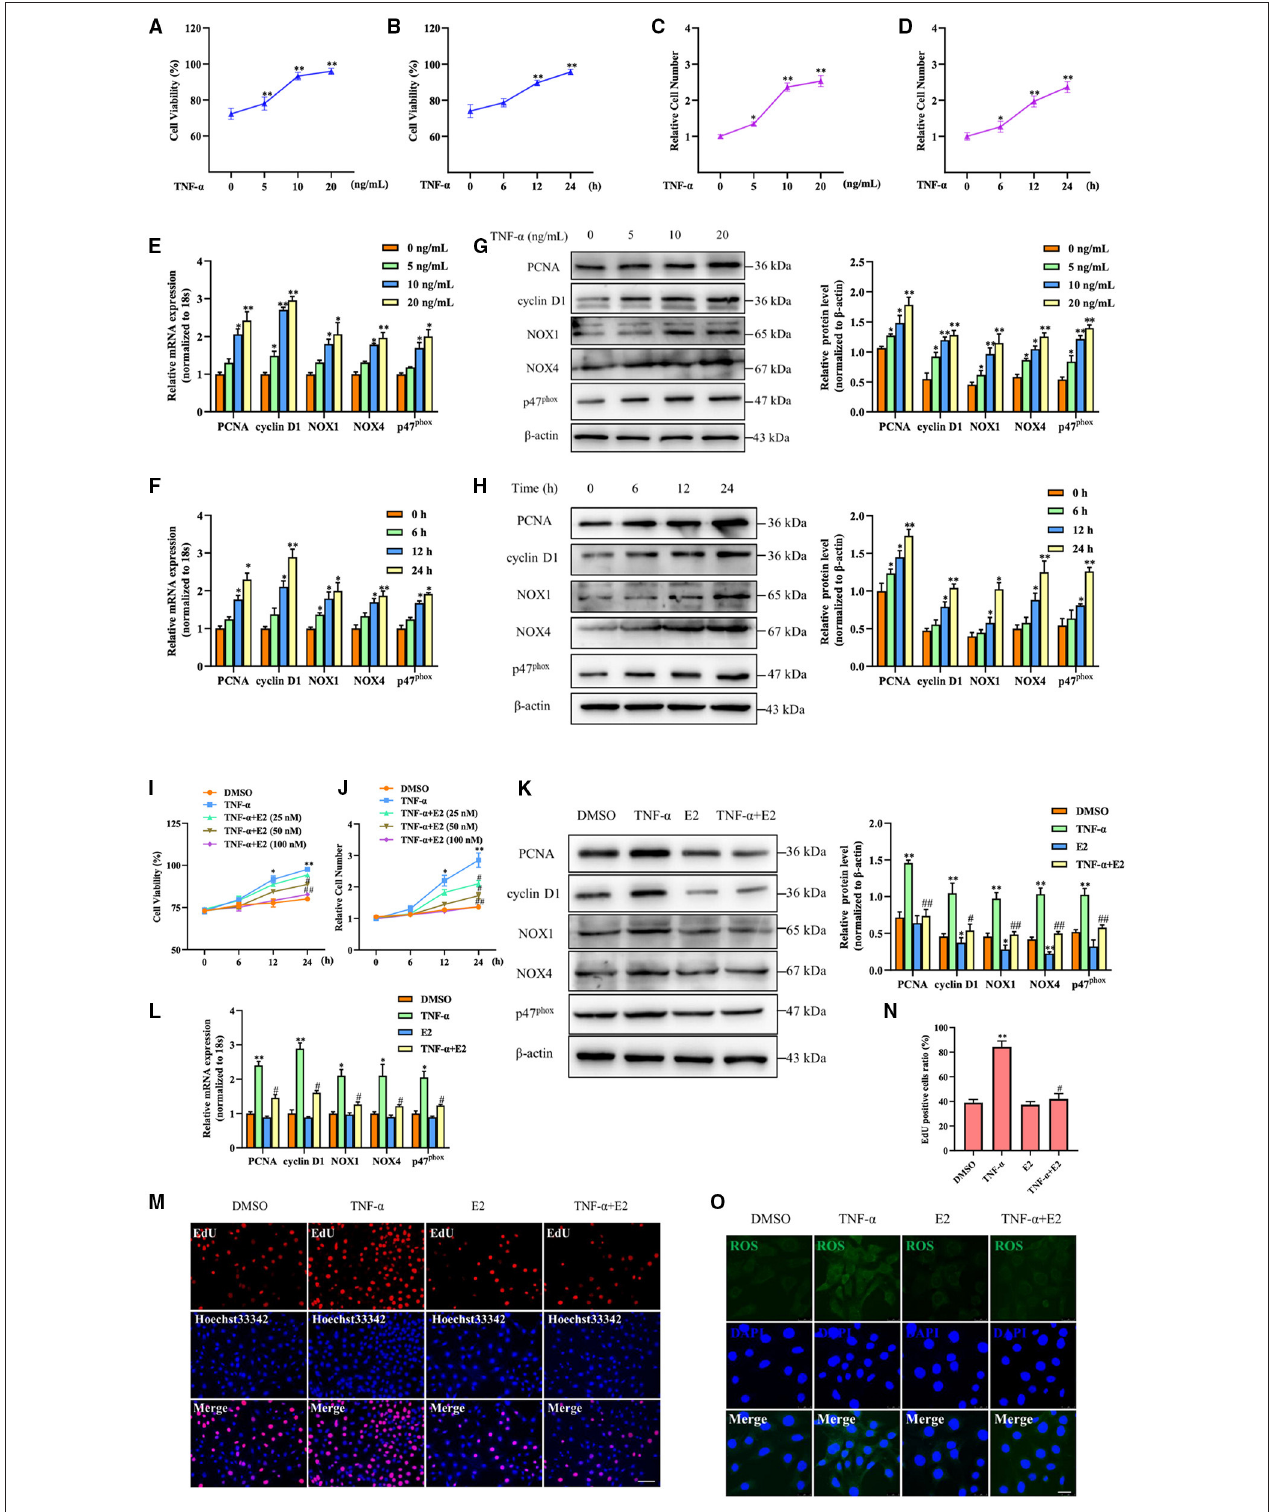
FIGURE 2 | E2 inhibits TNF- α -induced proliferation and oxidative stress in VSMC. (A–H) VSMCs were stimulated with TNF- α for indicated doses and times. The cell viability was determined by MTS assay (A,B) . * p < 0.05 and ** p < 0.01 vs. untreated group, respectively. Cell counting was carried out using a Countess